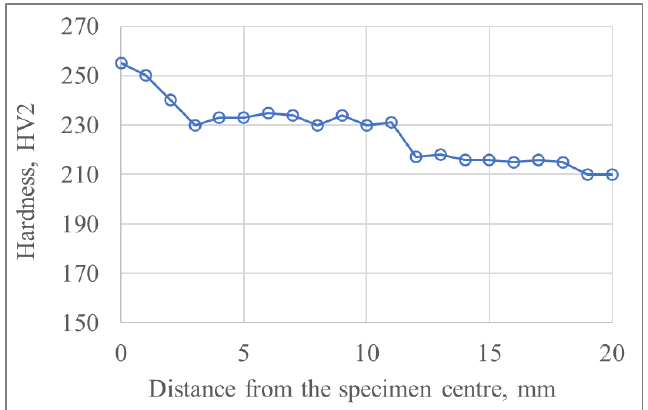
Figure 17. Hardness trend along the longitudinal direction of the specimen in USIBOR ® 2000 (Gleeble thermal cycle of TBH approach).